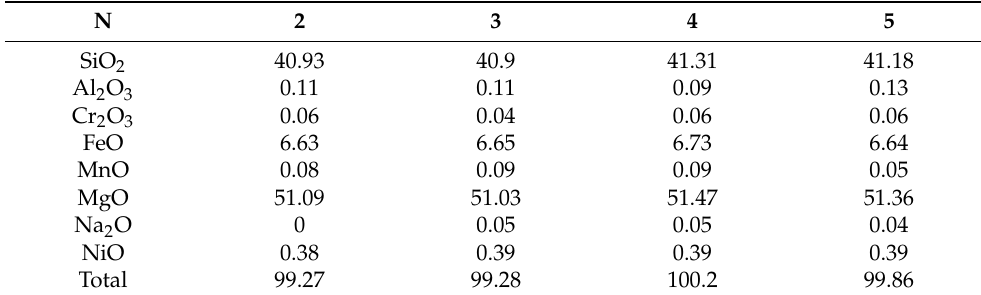
Figure 2. Elemental maps of olivine around diamond. The first left picture shows olivine sections around the diamond analyzed using TESCAN: the numbers 2 – 5 correspond to numbers (N) in Table 2. Table 2. Composition of the olivine around the diamond inclusion (wt%).